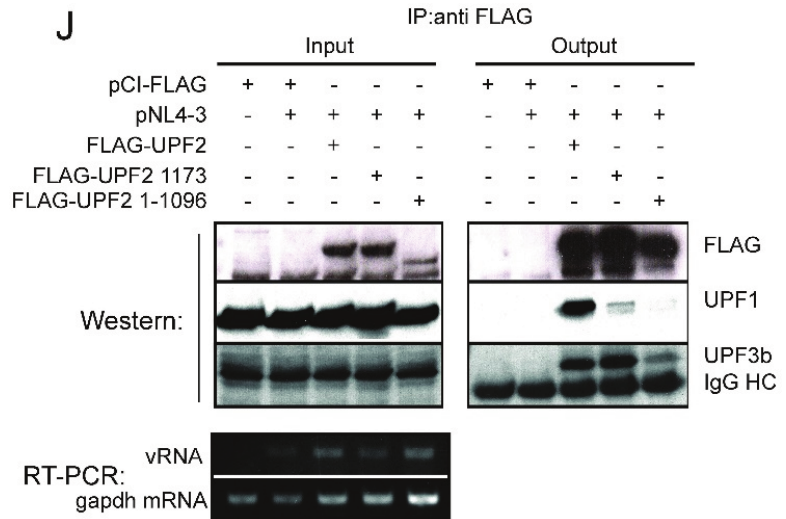
Figure 7. UPF3aL and UPF2 block vRNA export by associating to UPF1 as determined by